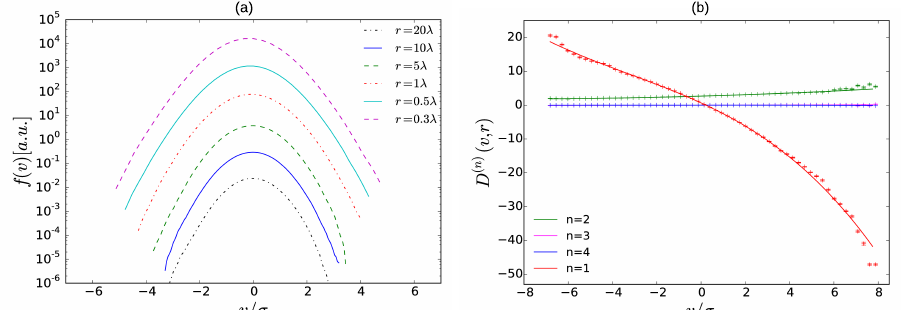
Figure 18. ( a ) evolution of the velocity increment PDF in scale for the purely nonlocal case α = 0. The PDFs exhibit self-similarity in the inertial range; ( b ) estimation of the Kramers–Moyal coefficients D ( n ) ( v , r = L /2 ) from DNS of the purely nonlocal case α = 0. The fits correspond to polynomials of the order n of the coefficient except for n = 1 where a polynomial of order three has been used. The reduced Kramers–Moyal coefficients have been determined according to K 1 = 0.3108 ± 0.0002,